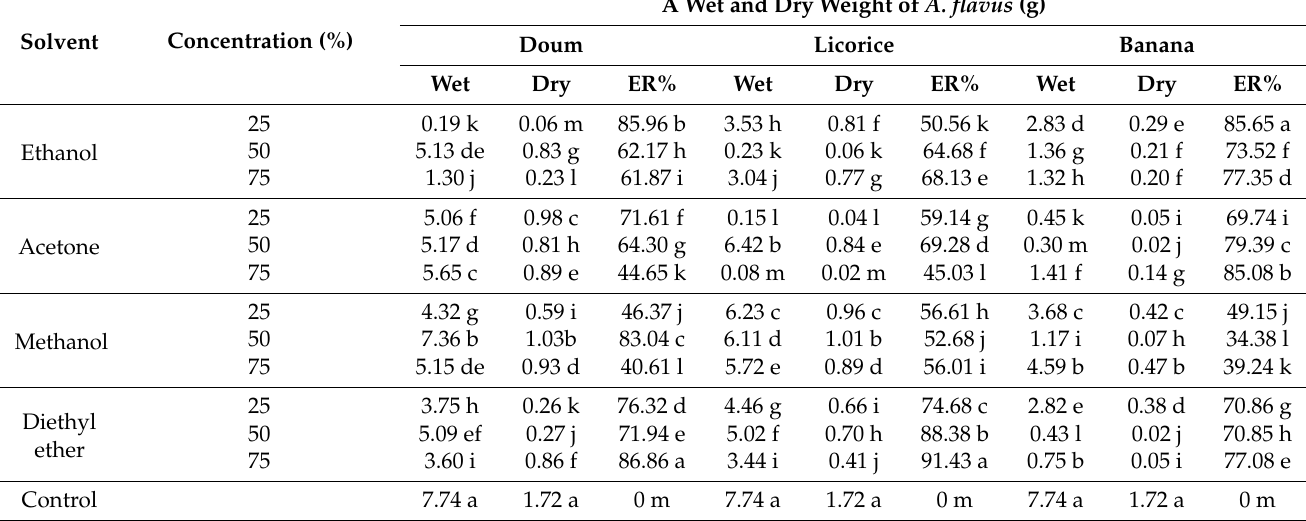
Table 3. Effect of the applied plant extracts on the wet and dry weight of A. flavus mat and the efficacy ratio of AFB1 production inhibition